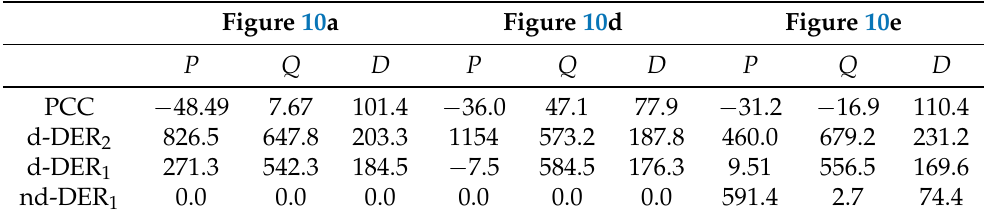
Figure 10. Experimental results: full current control with assorted inverters and variable generation capability. ( a ) d-DER 1 emulates an nd-DER with 20% of generation capability; ( b ) d-DER 1 emulates an nd-DER transiting from 20% to null generation capability; ( c ) zoom-in view of ( b ); ( d ) steady-state condition of ( c ); ( e ) case ( d ) considering nd-DER 1 injecting active power. From top to bottom: PCC voltage and current, d-DER 2 and d-DER 1 currents. The results in ( e ) were measured using two oscilloscopes using AC line trigger mode. Table 4. Steady-state powers at the PCC and at DERs for Figure 10. Units: P (W), Q (VAR), and D